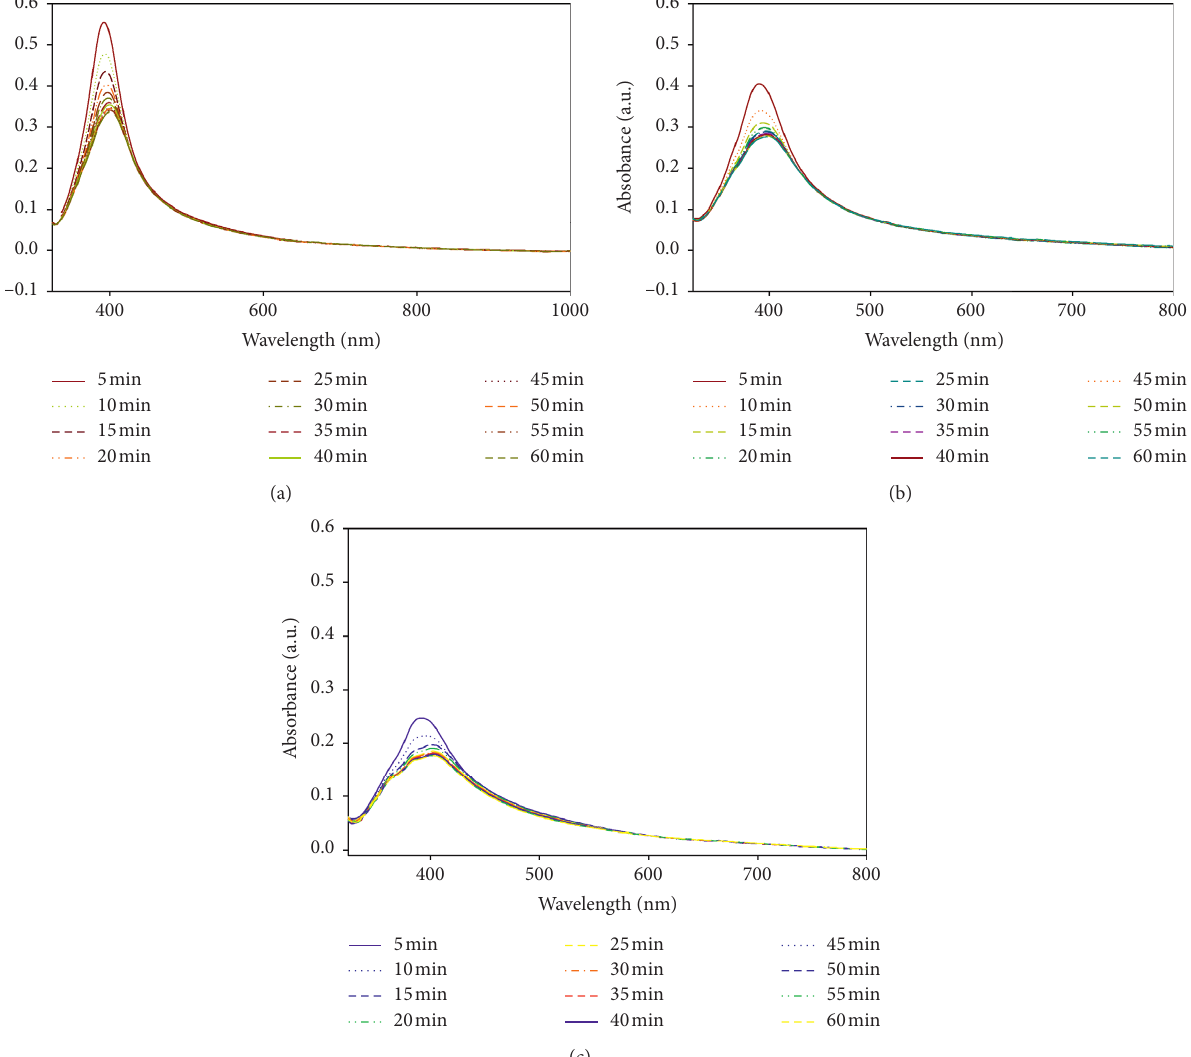
Figure 5: Effect of time (5–60min) on the absorbance of the green fabricated silver nanoparticles after adding different amounts of ammonia solution: (a) 1000ppm, (b) 2000ppm, and (c) 3000ppm.